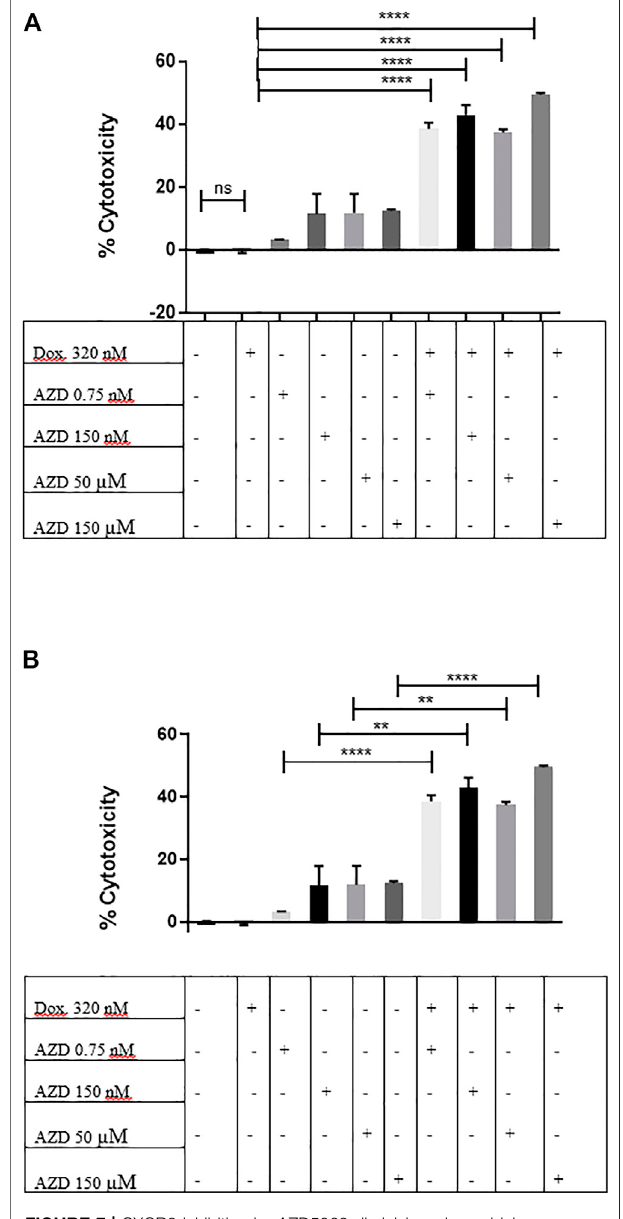
FIGURE 7 | CXCR2 inhibition by AZD5069 diminishes doxorubicin chemoresistance in MDA-MB-231 mammospheres. (A) Cell cytotoxicity in control and treated conditions obtained from the LDH assay. Data are expressed as cytotoxicity percentage. Dox: doxorubicin; AZD: AZD5069. p values: The cytotoxicity of each combined treatment group was compared to the cytotoxicity of doxorubicin alone using unpaired Student ’